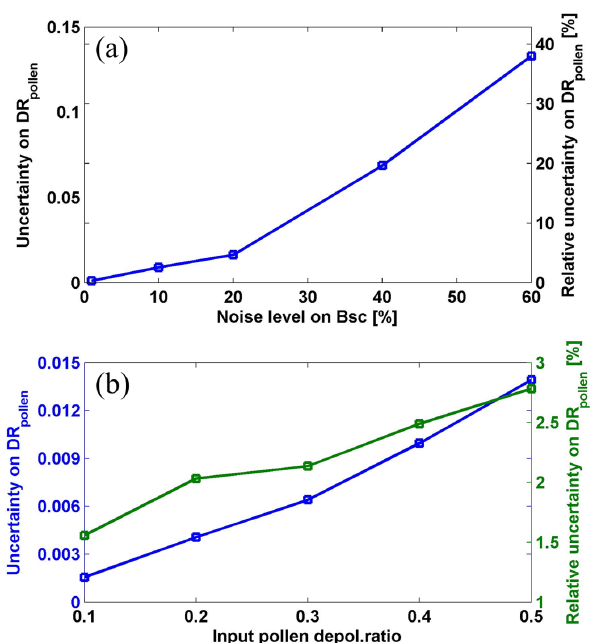
Figure 7. Examples of estimated uncertainties (left y axis) and relative uncertainties (right y axis) on retrieved pollen depolariza- tion ratio (DR pollen ) at 532nm against (a) the applied noise lev- els on backscatter coefficient (Bsc), and (b) the initial input values of DR pollen , using Monte Carlo method. The initial input value of DR pollen is 0.35 for the example in (a) . The noise level on backscat- ter coefficient (Bsc) is 10% for the example in (b) .